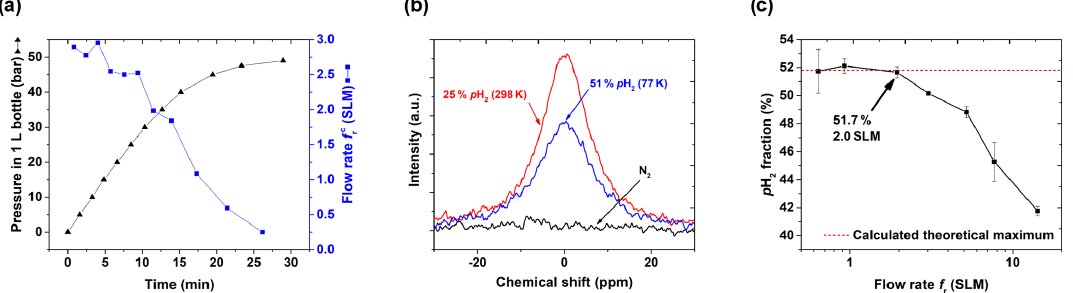
as a function of time T rt P stand , and (c) f p H as a function of f r 2 2